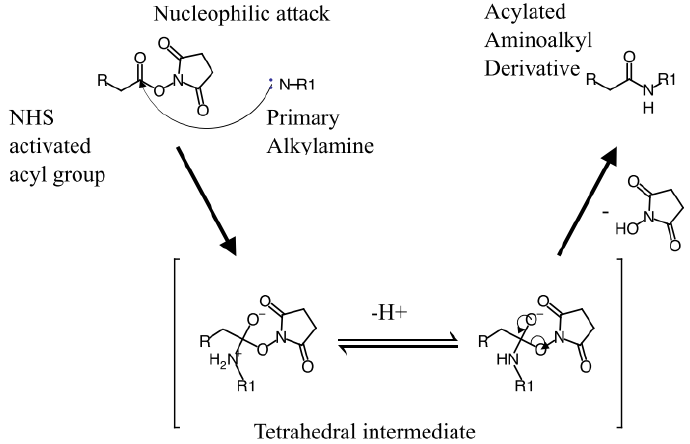
Figure 18. Acylation mechanism through the nucleophilic attack forming a tetrahedral intermediate and finally the product.